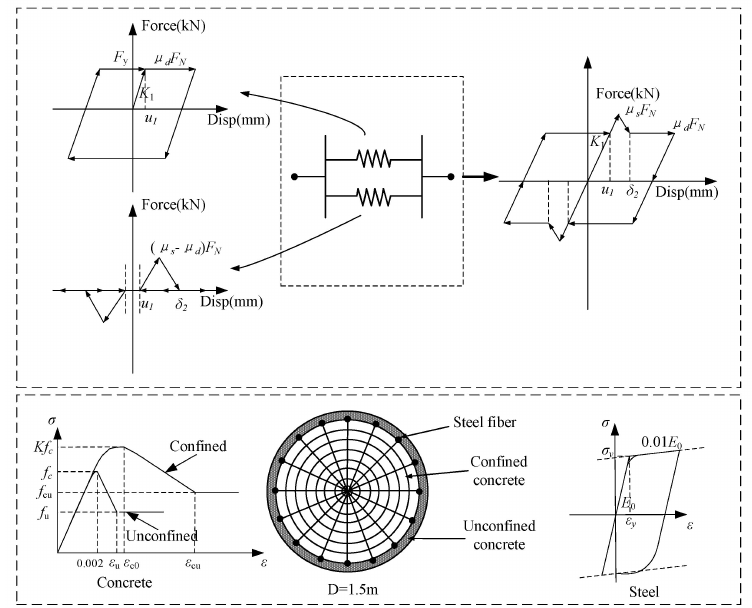
Figure 13. Models of components of the prototype